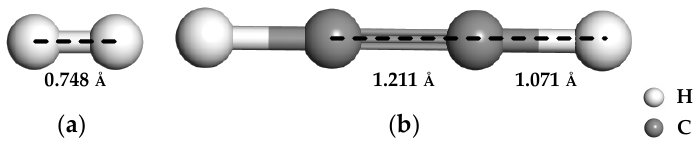
Figure 1. The structures of H 2 ( a ) and C 2 H 2 ( b ).